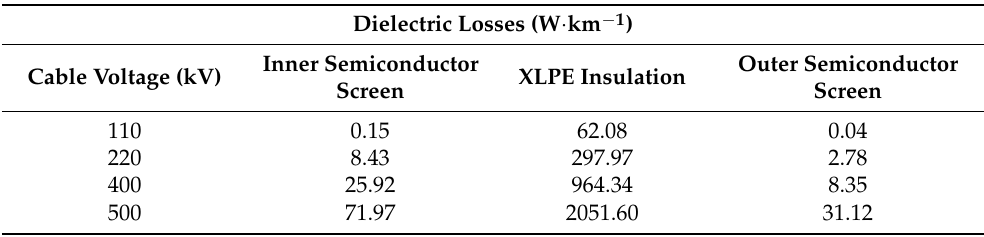
Table 7. Dielectric losses in semiconductor screens and XLPE insulation of high-voltage cables with 110, 220, 400, and 500 kV for 1 km of cable in case γ =